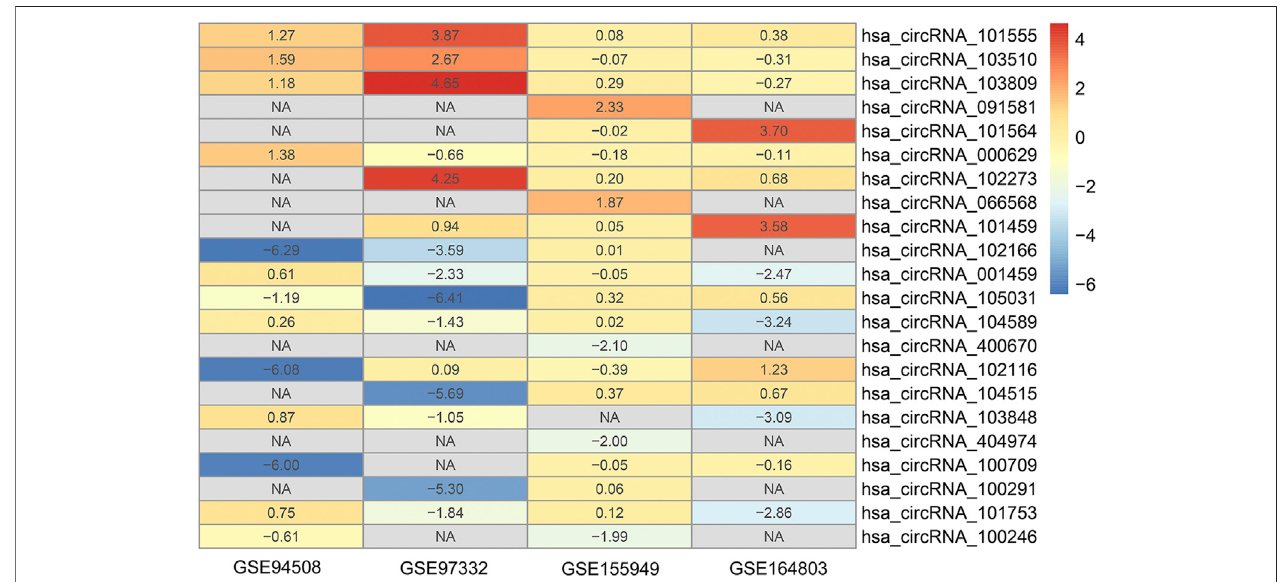
FIGURE 3 | Heatmap of the 22 differentially expressed circRNAs identi fi ed by the robust rank aggregation